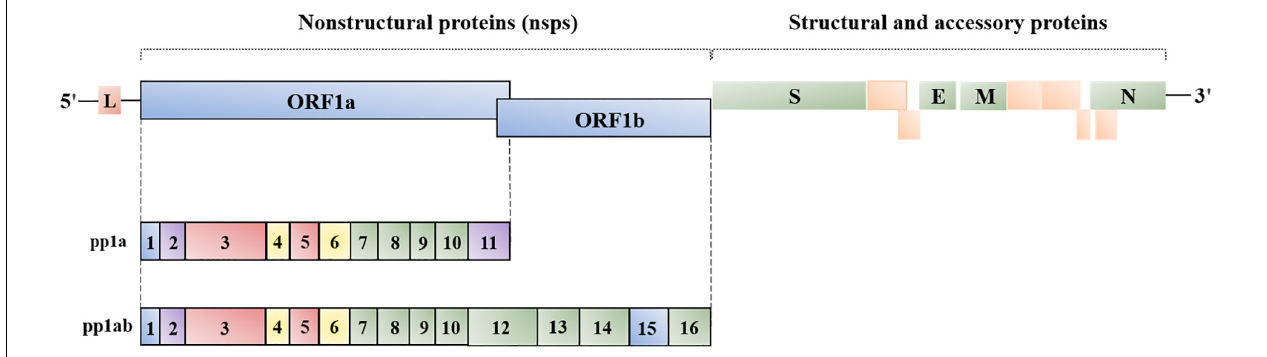
FIGURE 1 | Genome organization of coronavirus. L, leader; ORF1a/1b, replicase, encoding nsp1-16 ( γ - and δ -coronavirus lack nsp1); S, spike; E, envelope; M, membrane; N, nucleocapsid. The location and number of accessory proteins vary in different coronaviruses.